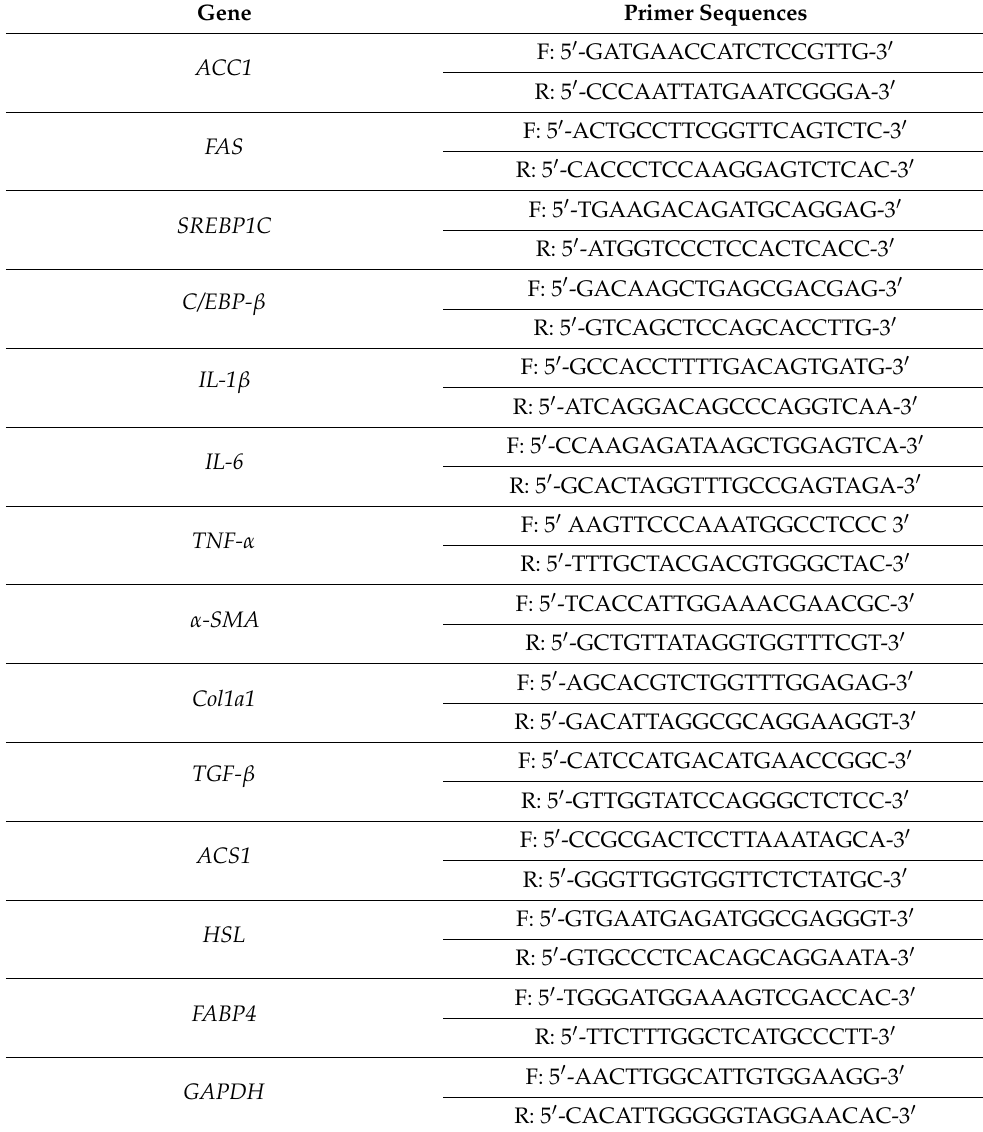
Table 1. Primer sequences used in real-time PCR quantification of